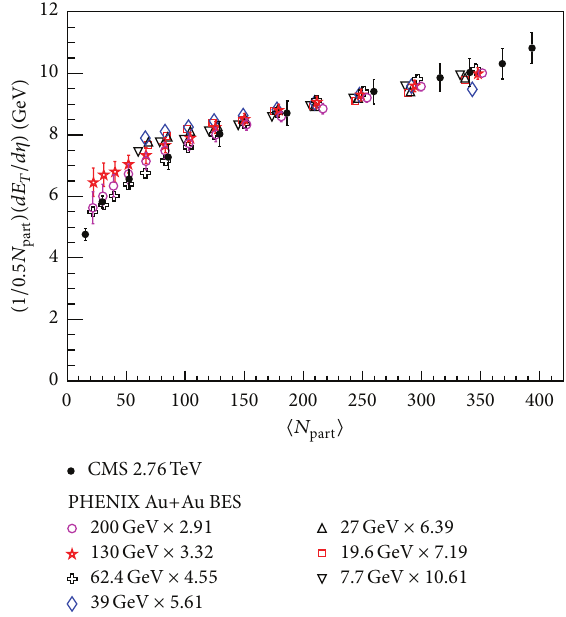
Figure 36: Collision energy dependence of midrapidity (1/(𝑁 /𝑑𝜂) . Shown are different phenomenological fitting func- 2))(𝑑𝐸 𝑇 tions to explain the transverse energy production.